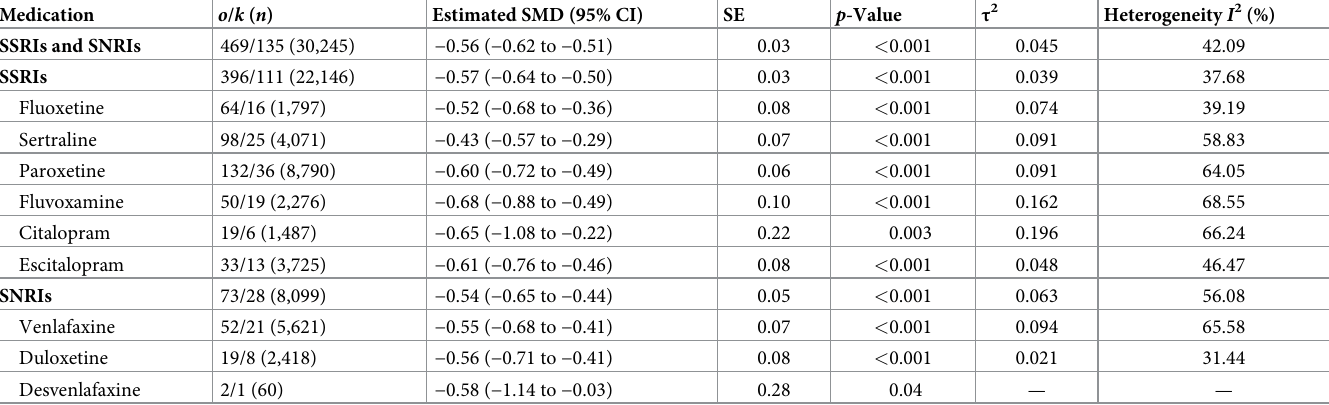
Table 1 InTable 1 ; Ireplacedthezerovaluesfor ? 2 andI 2 fordesvenlafaxinewithdashes ; undertheassumptionthatthesemeasurementsaren 0 tapplicableinthiscaseofasinglestudy : Ifthisisnotcorrect ; pleaseedit : . SMD between medication and placebo for the primary outcome (aggregate measure of mental-health-related symptoms) according to each medication class and each medication within the same